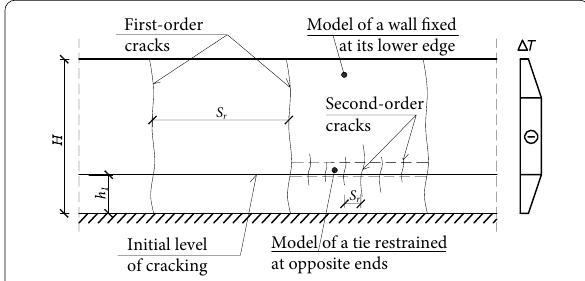
Fig. 5 Assumption of computational model concerning the type of cracks and the place of their initiation (Zych,